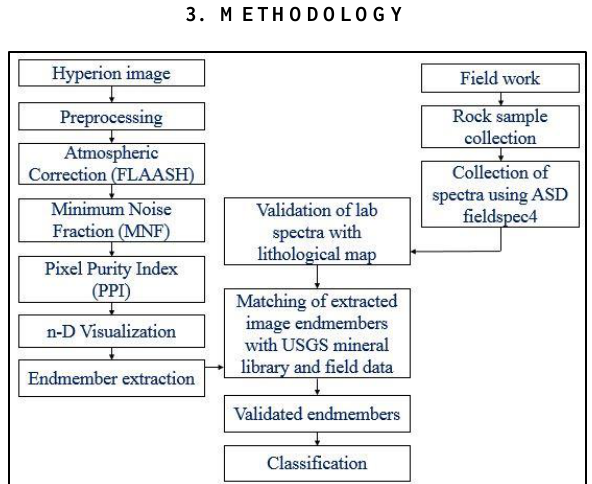
Figure 2. Flowchart depicting the methodology adopted for this study